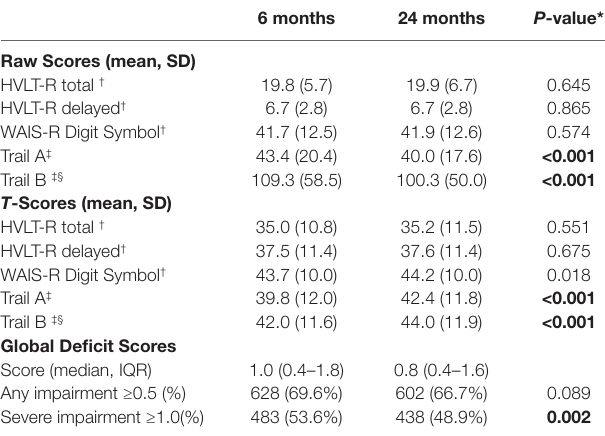
TABle 2 | Neuropsychological test scores at 6- and 24- month assessments (N = 902).